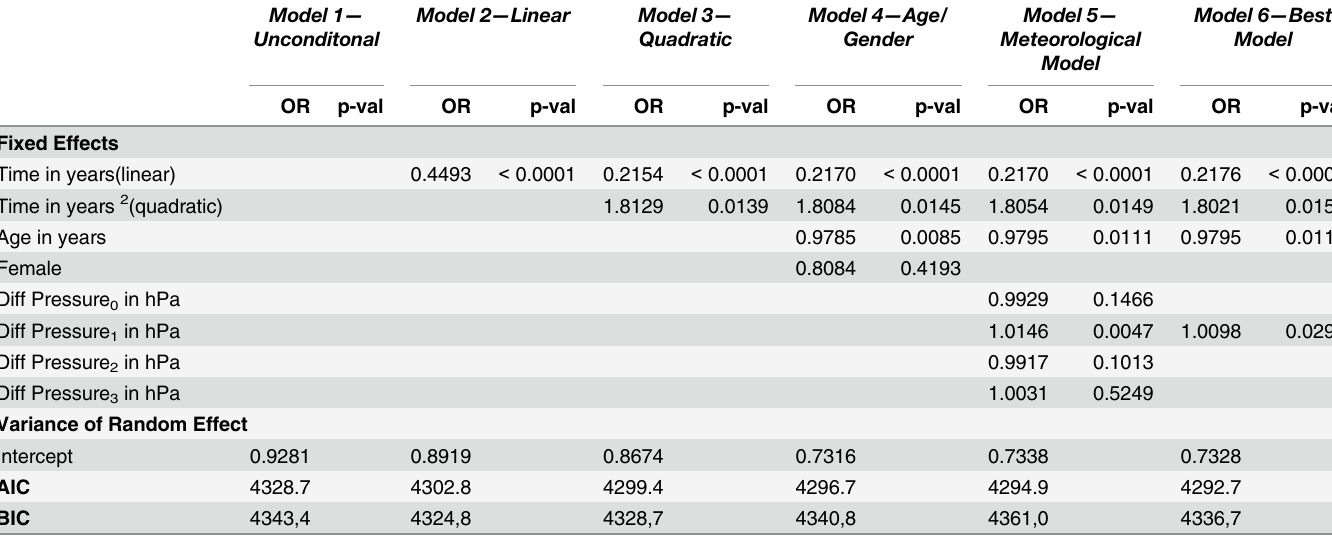
Table 5. Results of the generalized linear mixed models presented with Odds Ratios (OR), p-values (p-val), Akaike Information Criteria (AIC) and Bayesian Information Criteria